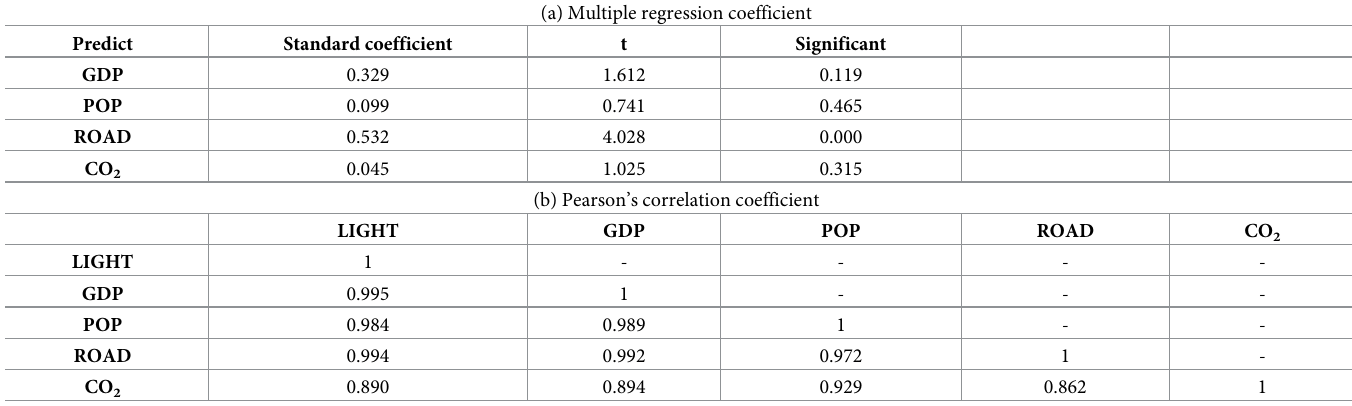
Table 7. Multiple regression coefficient table and Pearson correlation coefficient table of NTL density in Indian state. (a) Multiple regression